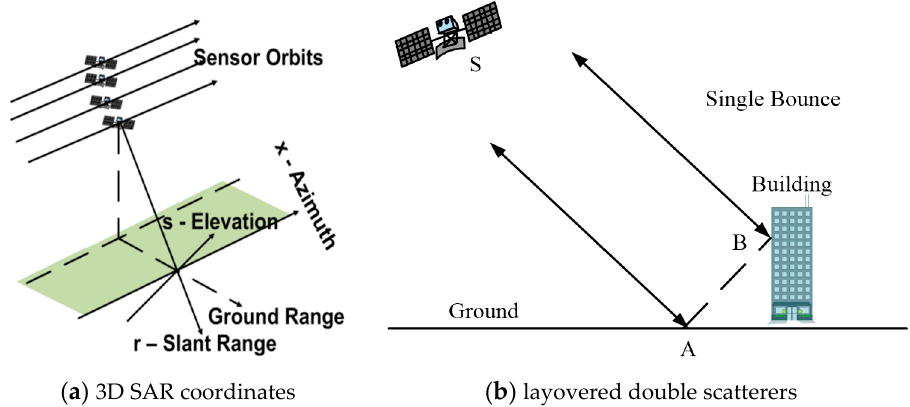
Figure 1. 3D SAR coordinate system ( a ) and typical layover effect of double single-bounce scatterers in urban SAR images ( b ).